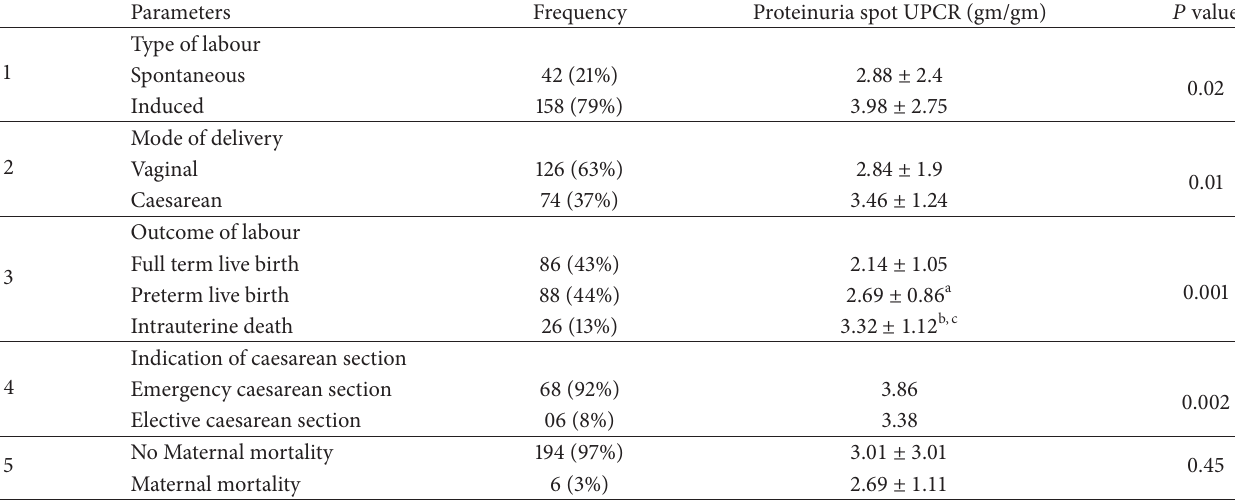
Table 3: Maternal outcome and spot UPCR in the patients of preeclampsia.